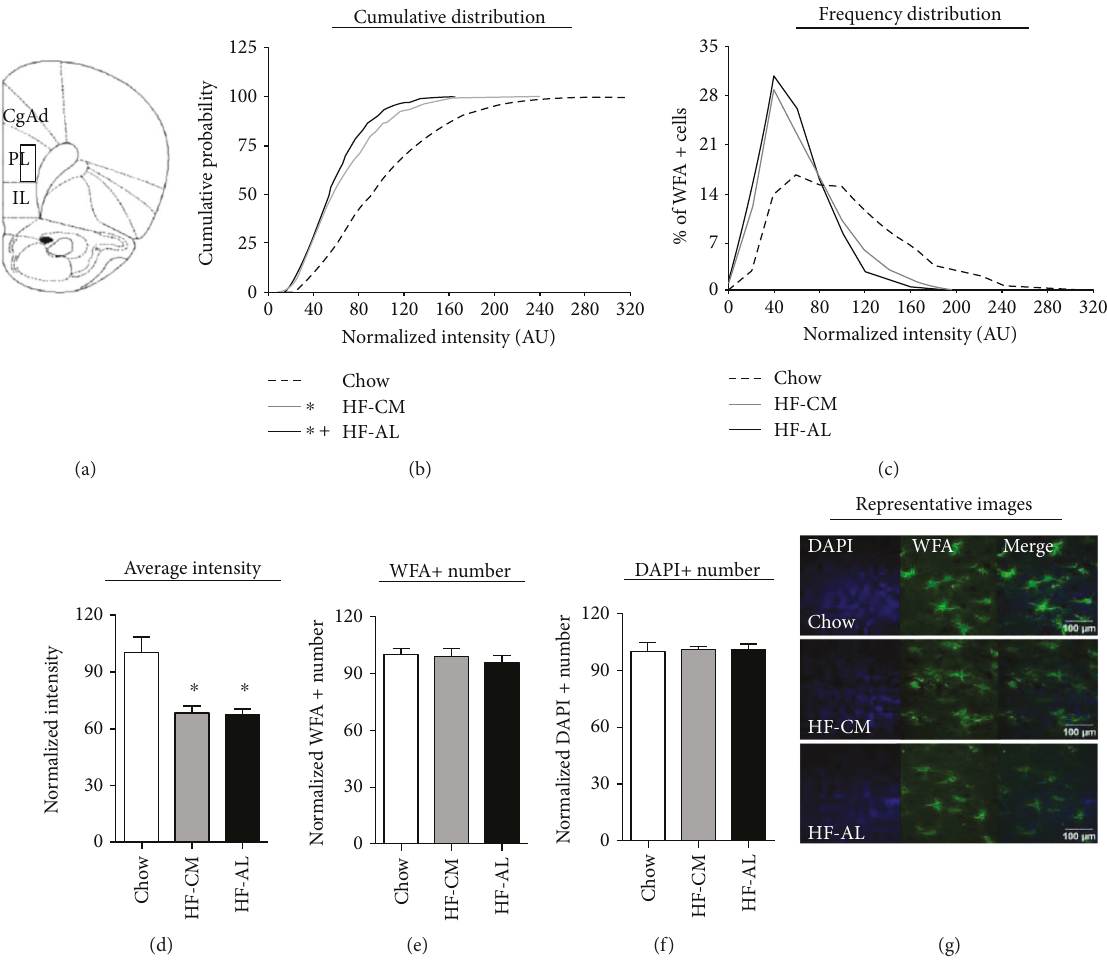
Figure 2: Consumption of a high-fat diet attenuates PNN intensity, but not PNN number, in the prelimbic prefrontal cortex (PL-PFC). (a) Schematic of the region analyzed. (b) Normalized PNN intensity expressed as a cumulative probability for chow (dashed line), HF-CM (gray line), and HF-AL (black line) groups. (c) Normalized PNN intensity expressed as a frequency distribution for chow, HF-CM, and HF-AL groups. (d) Normalized average PNN intensity among chow (white), HF-CM (gray), and HF-AL (black) groups. (e) PNN number, measured by the number of WFA+ cells. (f) Cell density, measured by the number of DAPI+ cells. (g) Representative images shown as max projections of z-stacks. Values represent the mean ± SEM ( ∗ / + p < 0 05 ). ∗ indicates signi fi cant di ff erence between HF-CM and chow as well as between HF-AL and chow. + indicates signi fi cant di ff erence between HF-AL and HF-CM